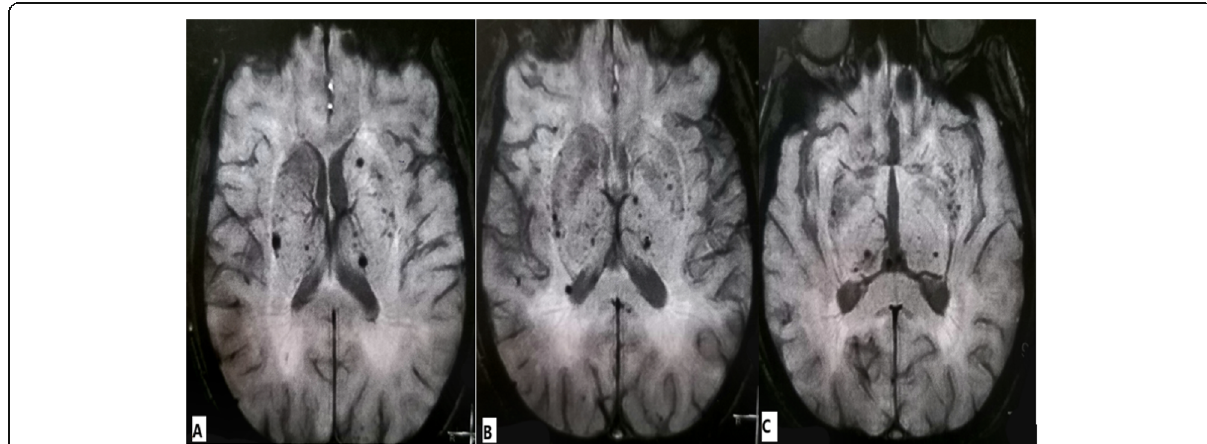
Fig. 2 Deep type cerebral microbleeds. Axial brain SWI images ( a – c ) show multiple signal loss areas of cerebral microbleeds in the periventricular